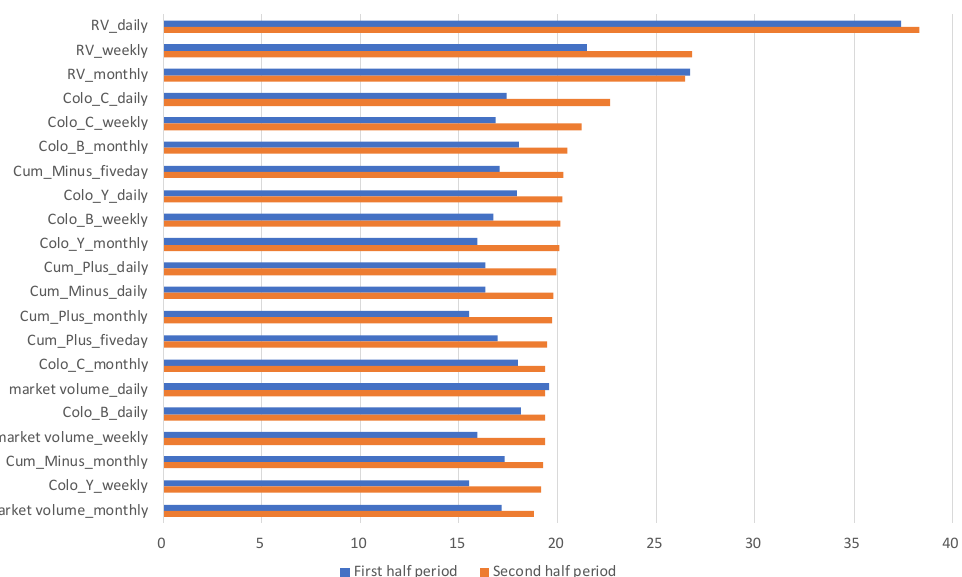
Figure 5. Importance variable changes from the first half period to the second half period sorted by second-half period base.